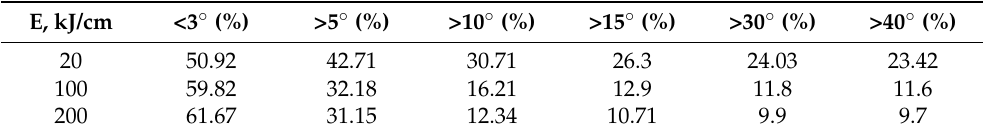
Table 5. Percentage of different grain misorientation